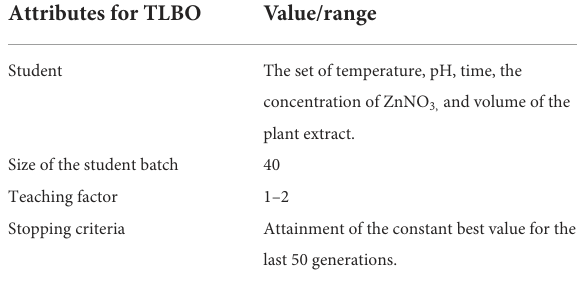
TABLE 1 The parameters selected to conduct the